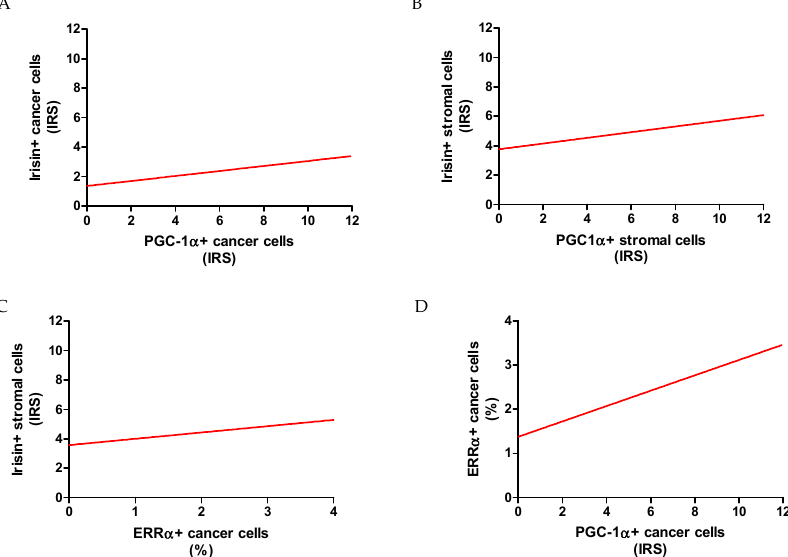
Figure 8. Correlations between irisin expressed in cancer cells with PGC-1 α expressed in cancer cells ( A ) and stromal cells with PGC-1 α (stromal cells) ( B ), and ERR α receptor ( C ). Correlations between ERR α and PGC-1 α in NSCLC (n = 860) cancer cells ( D ).